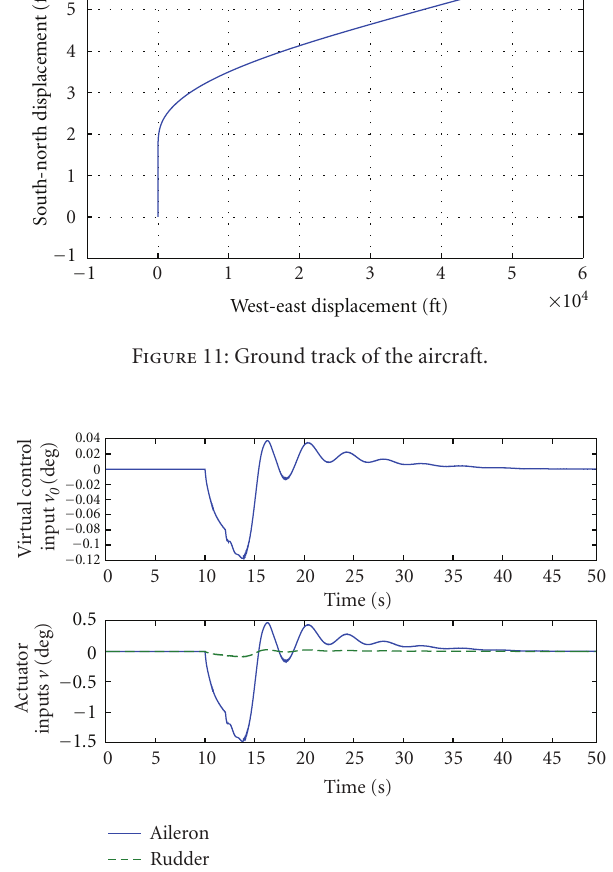
Figure 12: Time history of virtual control signal and actuator